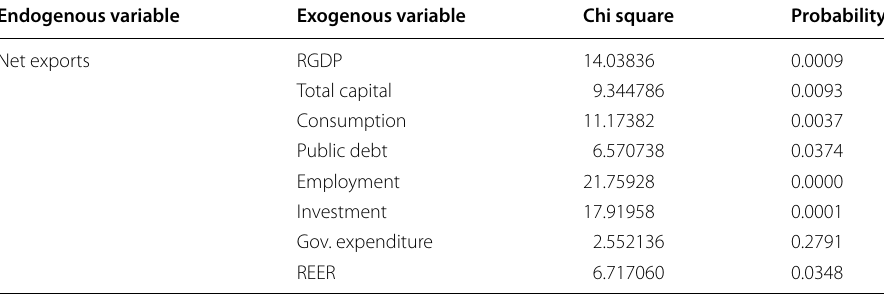
Table 13 Wald test results for Eq. (9). Source : Author’s calculations Endogenous